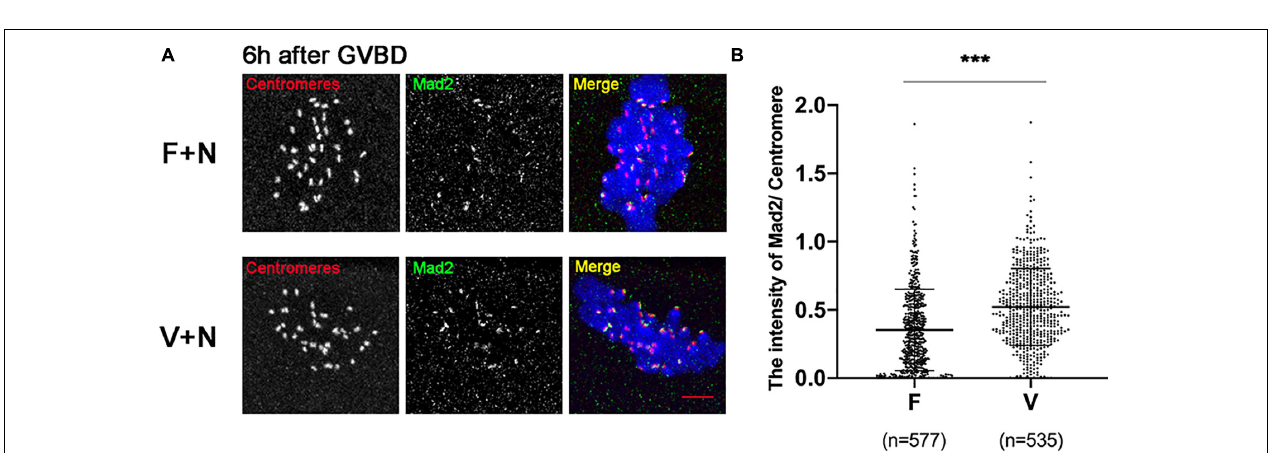
FIGURE 4 | Mad2 was recruited onto kinetochores after treatment with nocodazole. (A) 16 fresh oocytes and 16 vitrified oocytes were treated with nocodazole (400 nM) at 5 h after GVBD. Then, ooctyes were fixed at 6 h after GVBD to detect centromeres (Red), Mad2 (Green), and chromosomes (Blue). Scale bar: 5 µ m. (B) The intensityof Mad2/Centromere was quantified in F+N (fresh oocytes treated with nocodazole) and V+N (vitrified oocytes treated with nocodazole) group. F+V: n = 577; V+N: n = 535, n : the number of the Centromere. The experiments were replicated three times.